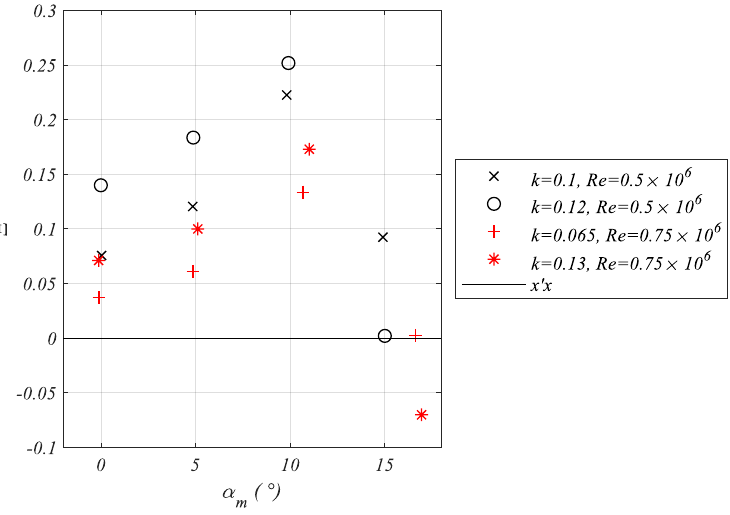
Figure 21. Aerodynamic damping coefficient versus mean angle of attack.